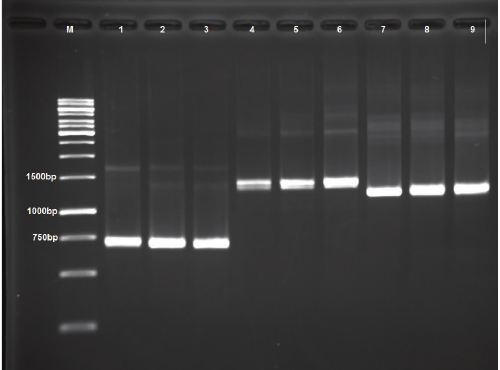
Figure 2: Agarose gel showing PCR product of pfcrt amplified in 3 fragments. Lane M: 1kb DNA ladder; lanes 1 to 3: first fragment of pfcrt gene ∼ 694 bp; lanes 4 to 6: second fragment of pfcrt gene ∼ 1370 bp; and lanes 7 to 9: third fragment of pfcrt ∼ 1235